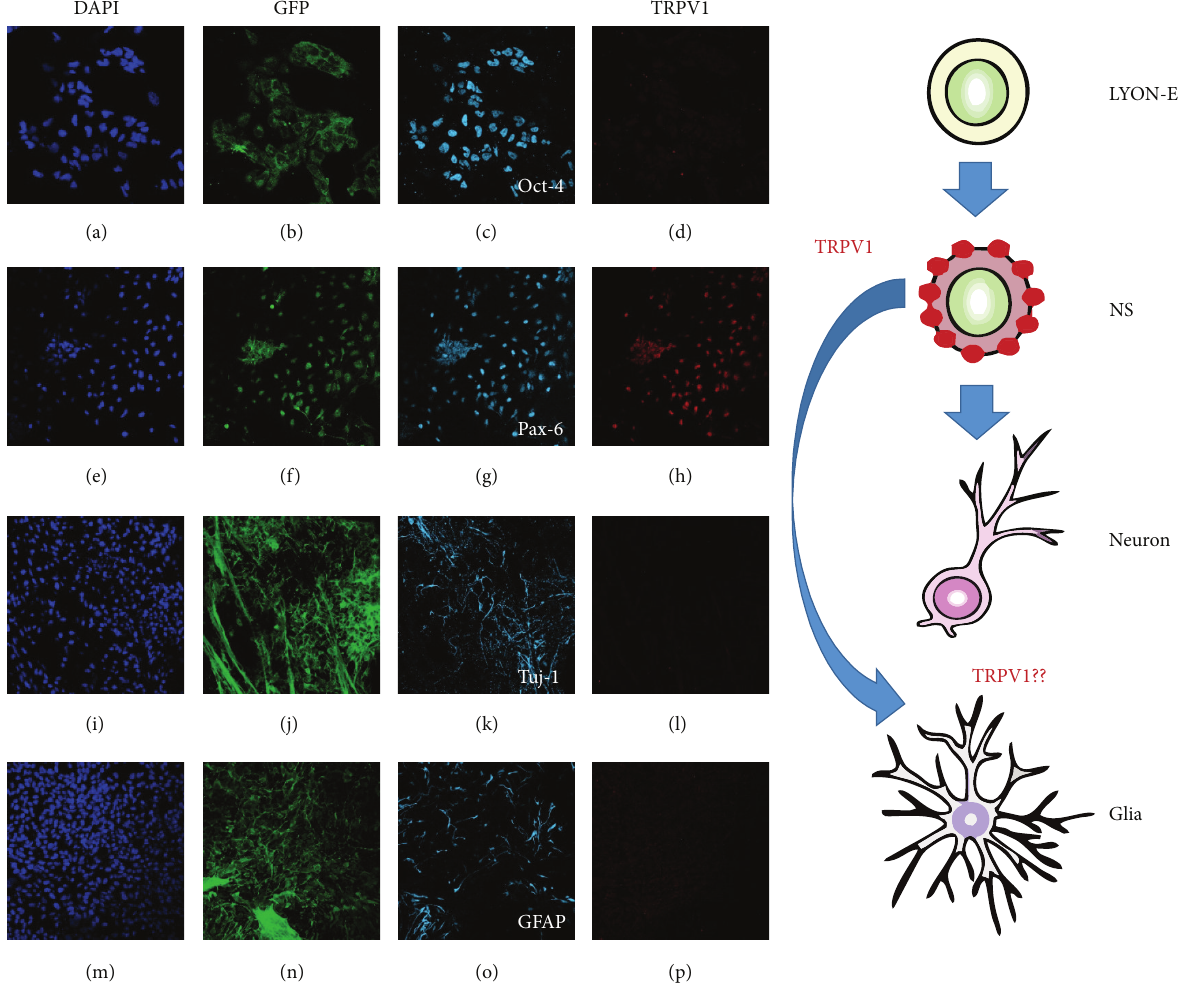
Figure 3: Expression of TRPV1 in neuronal differentiation process derived from LYON-ES. Determination of expression of TRPV1 by immunofluorescence staining for undifferentiated monkey ESCs stably expressing Tau-GFP (TAU-GFP LYON-ES1 line, a–d), NSCs (NS, e–h), neurons (i–l), and glial cells (m–p) derived from TAU-GFP-LYON-ES1 cells. At each stage, we performed immunofluorescence with antibodies against Oct4 (c) to identify LYON-ESCs, Pax6 for NSCs (g), 𝛽 -III-tubulin for neurons (k), glial fibrillary acid protein (GFAP) for glial cells (o), and TRPV1 (d, h, l, p). Each experiment was accompanied by nuclear staining with DAPI (a, e, i, m), all the cells having a GFP fused to the microtubule-associated protein tau (b, f, j, n). The magnification of images was 20x for LYON-ESCs and neurons, and 40x for NSCs and glia